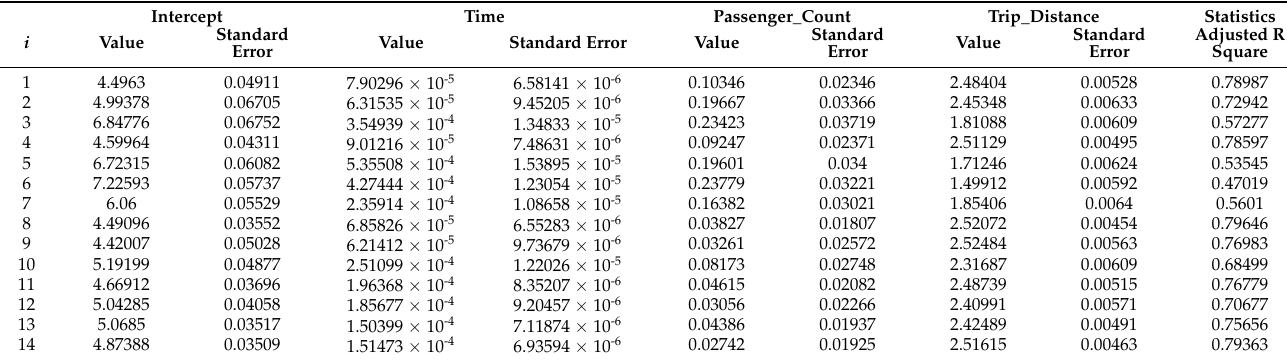
Table 2. Parameter table of local training model.